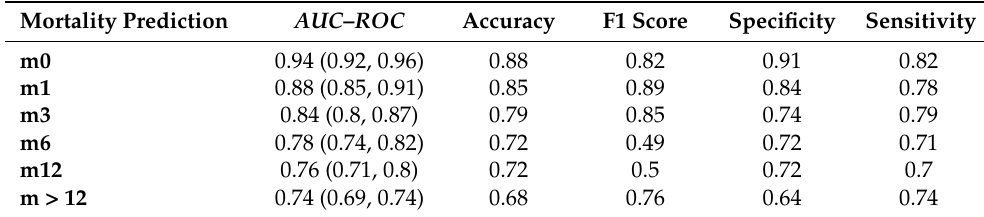
Table 3. Detailed metrics of performance for prediction of early and late mortality in ICU patients with cancer using all